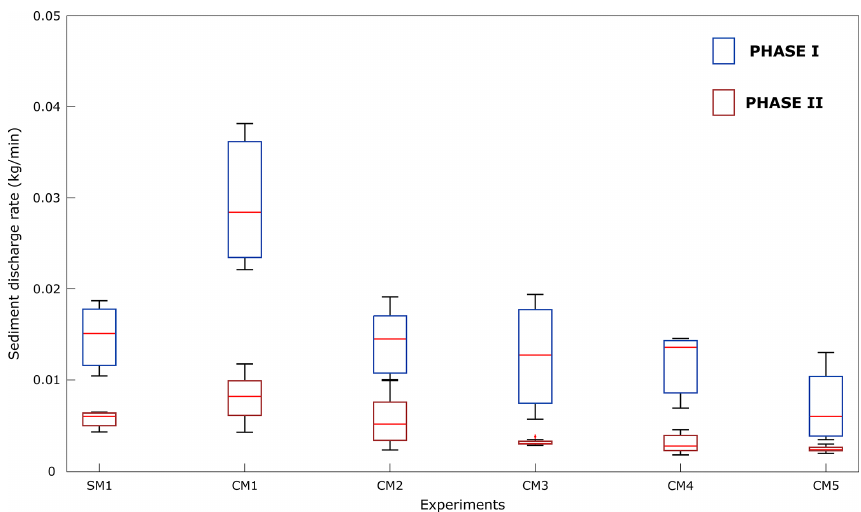
Figure 10. Box plot of the sediment discharge rate for phase I and phase II. The red lines indicate the median, and the bottom and top edges of the blue and brownish boxes indicate the 25th and 75th percentiles, respectively. The black markers outside the box cover the data point at < 25th and > 75th percentiles that are not considered